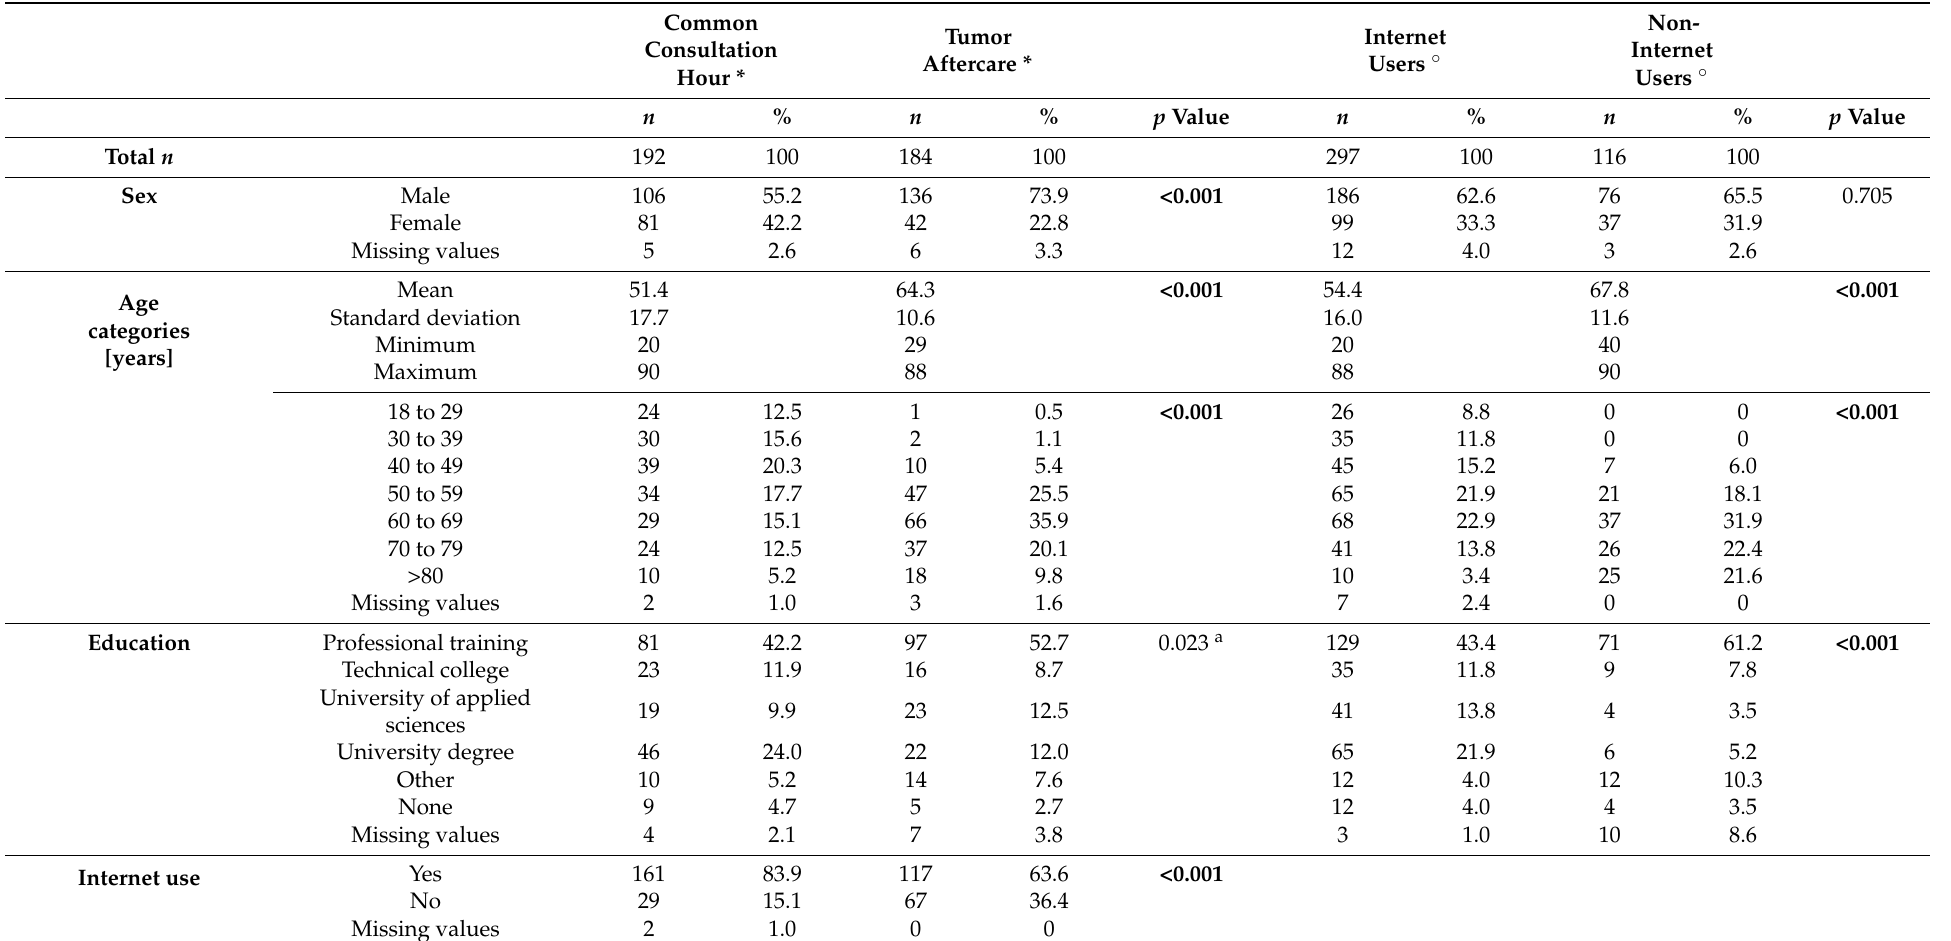
Table 1. Characterization of the patient cohort stratified according to either reason for consultation (common consultation hour vs. tumor aftercare) or internet use (yes vs. no); 415 questionnaires were